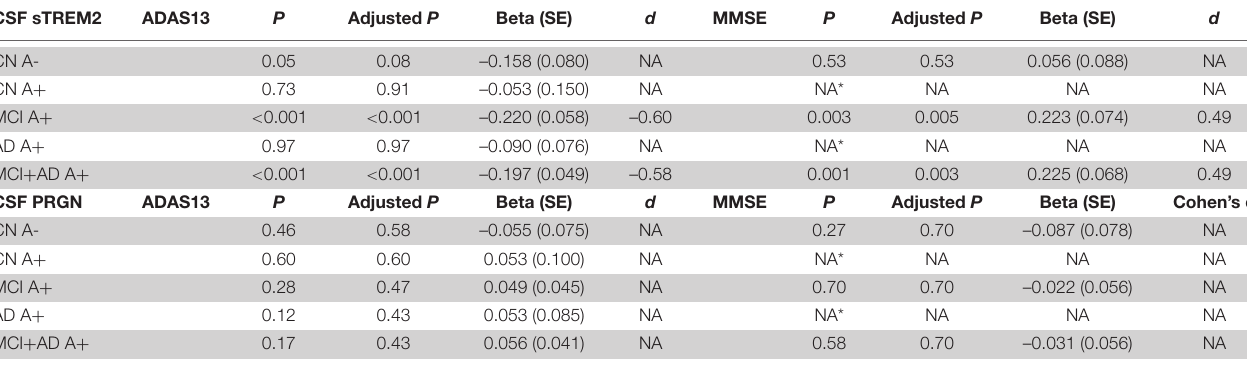
p refers to the significance of interaction effect of CSF sTREM2 concentration (or CSF progranulin) × time. The p-values are adjusted using false discovery rate (FDR). Beta (SE) refers to standardized regression coefficient with standard error. Cohen’s d refers to effect size of interaction effect of CSF sTREM2 concentration (or CSF progranulin) × time. In ADAS13, negative effect size d means higher concentrations are correlated with slower ADAS13 score increase, whereas positive effect size d means higher baseline concentrations are correlated with faster ADAS13 score increase. In MMSE, positive effect size d means higher concentrations are correlated with slower MMSE score decrease. *Means the model did not fit